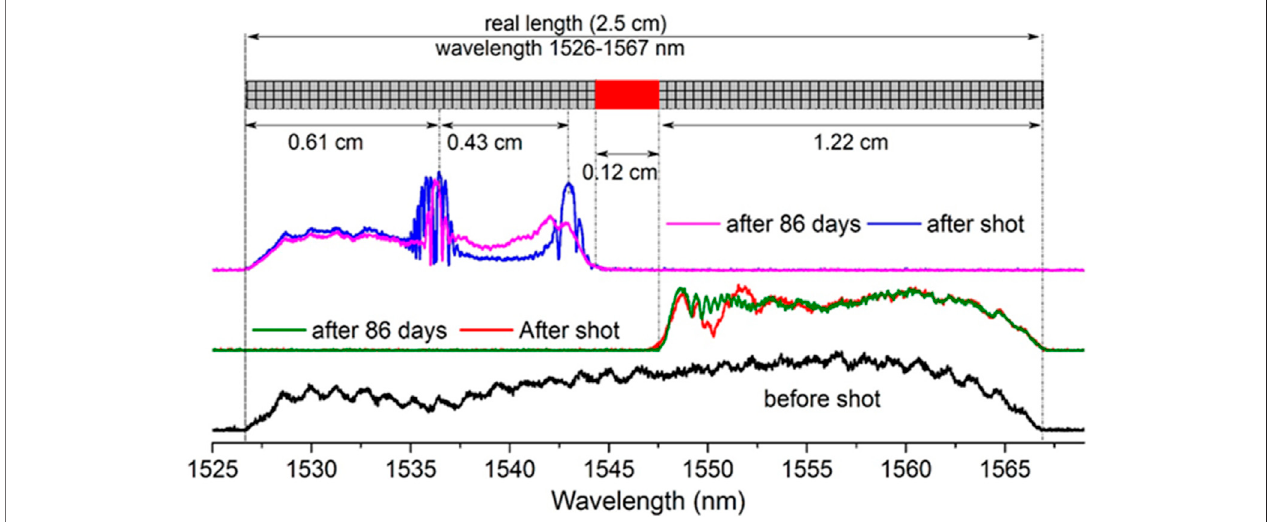
FIGURE5 | Spectra ofthe FBG before and after impact traced incascade forbetterclarity.FBG spectra before theimpact (black), thered and purple graphics are theFBGspectra(leftandrightside)justaftertheimpact,theblueandgreengraphicsaretheFBGspectra(leftandrightside)after86 days.Theemptypartinthemiddleis the broken